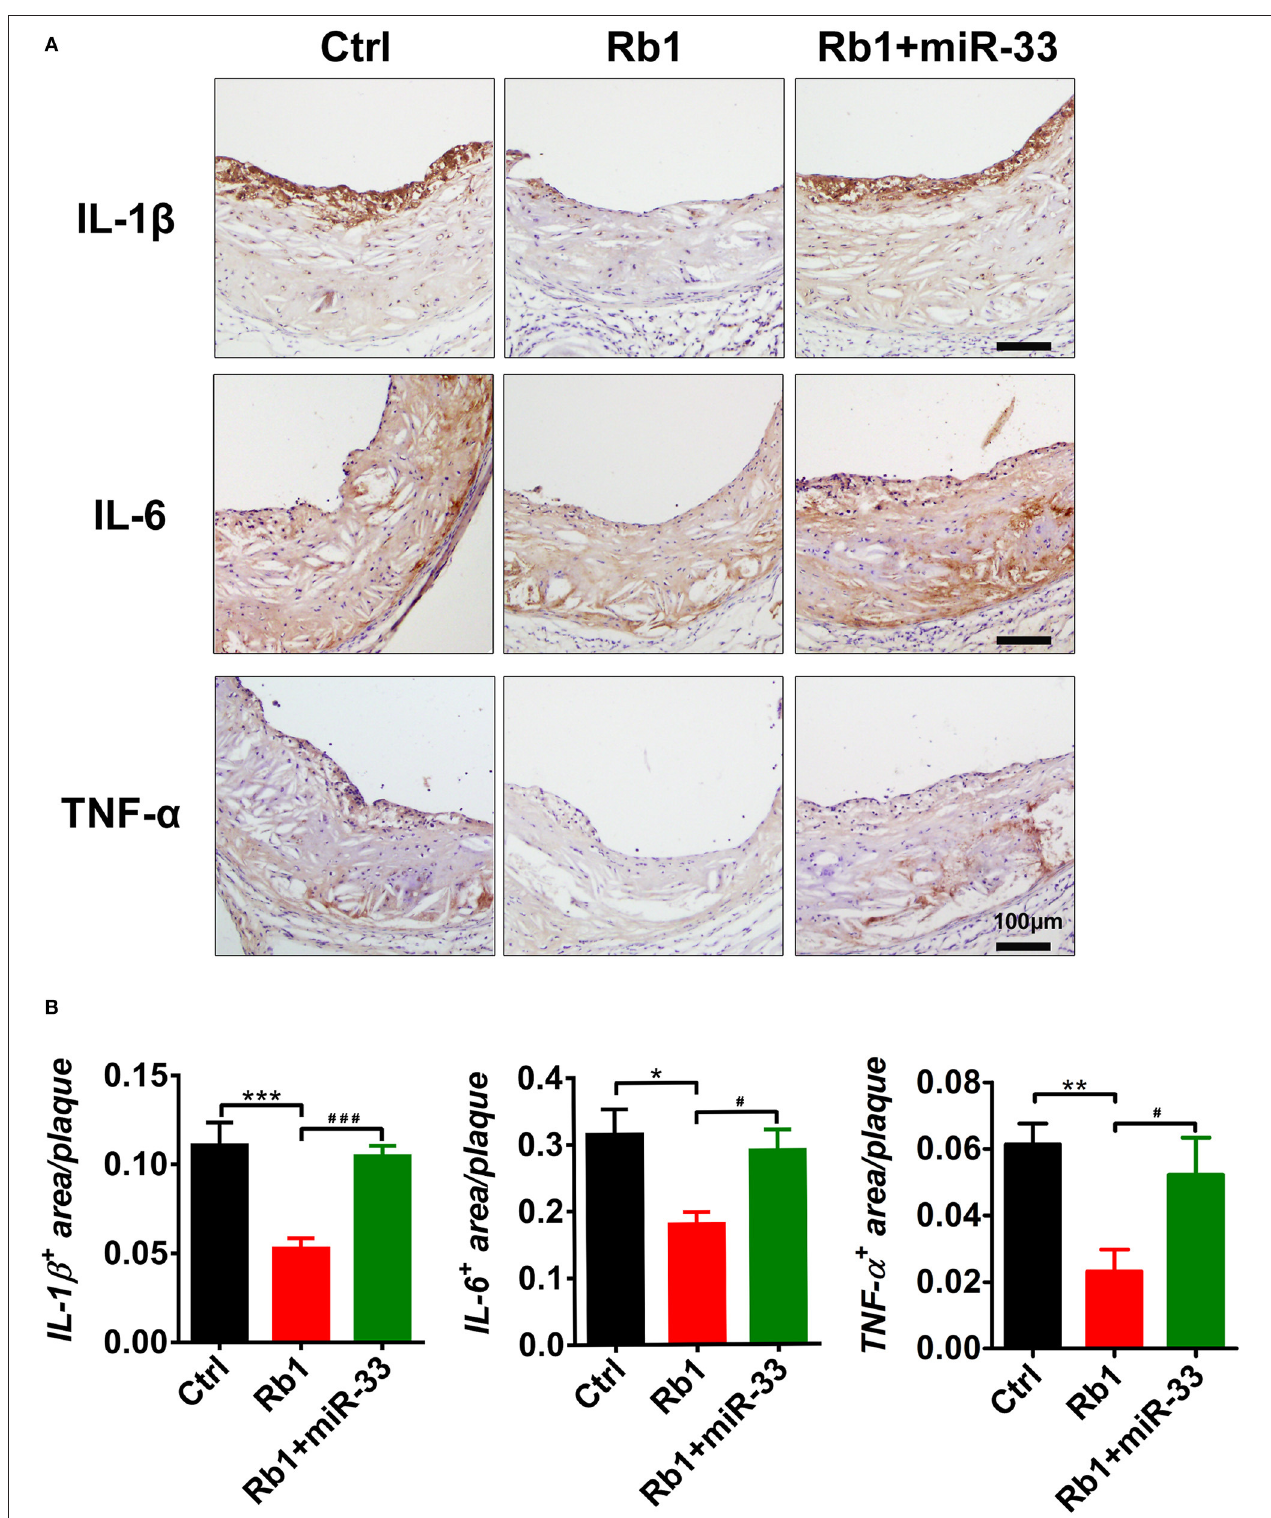
FIGURE 4 | Analysis of inflammation-related cytokines in atherosclerotic plaques of three groups of apoE − / − mice. (A) Immuno-histological analysis of cross sectional aorta roots of control group, Rb 1 -treated group as well as Rb 1 + miR-33 treated apoE − / − mice, by staining with anti-IL-1 β , anti-IL-6, and anti-TNF- α ( n = 10 ∼ 15/group). (B) Quantification of inflammatory cytokines positive area vs. total cross sectional plaque areas of control group, Rb 1 -treated group as well as Rb 1 + miR-33 treated apoE − / − mice ( n = 10 ∼ 15/group). * p < 0.05; ** p < 0.01; *** p < 0.001. # p < 0.05; ### p < 0.001, one-way ANOVA.